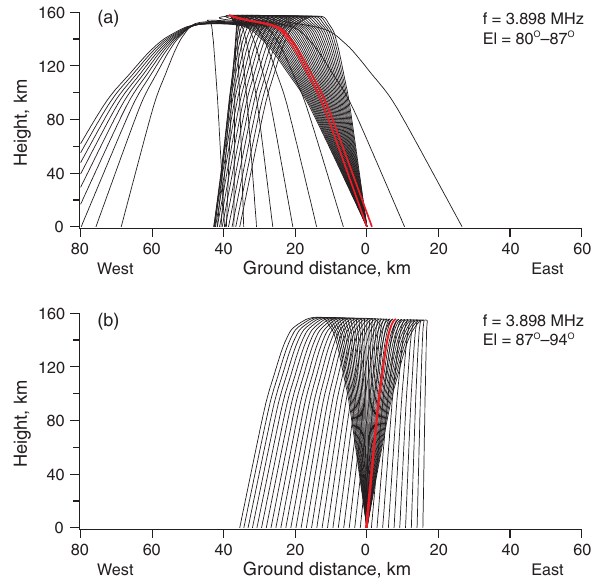
Figure 9. Ray plots for initial elevation angles from 80 to 87 ◦ (a) and 87 to 94 ◦ (b) with increments of 0.2 ◦ at a frequency of 3.898MHz. Red lines show ray paths that returned to the receiver